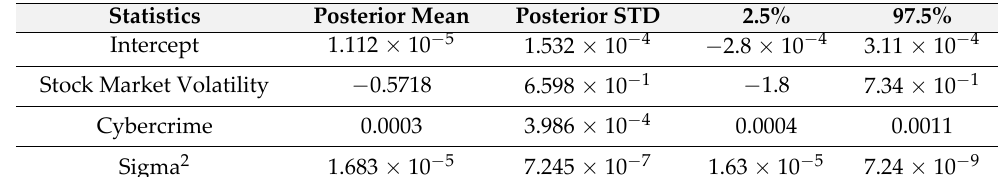
Table 5. BLR results with Return on Ethereum as dependent variable.